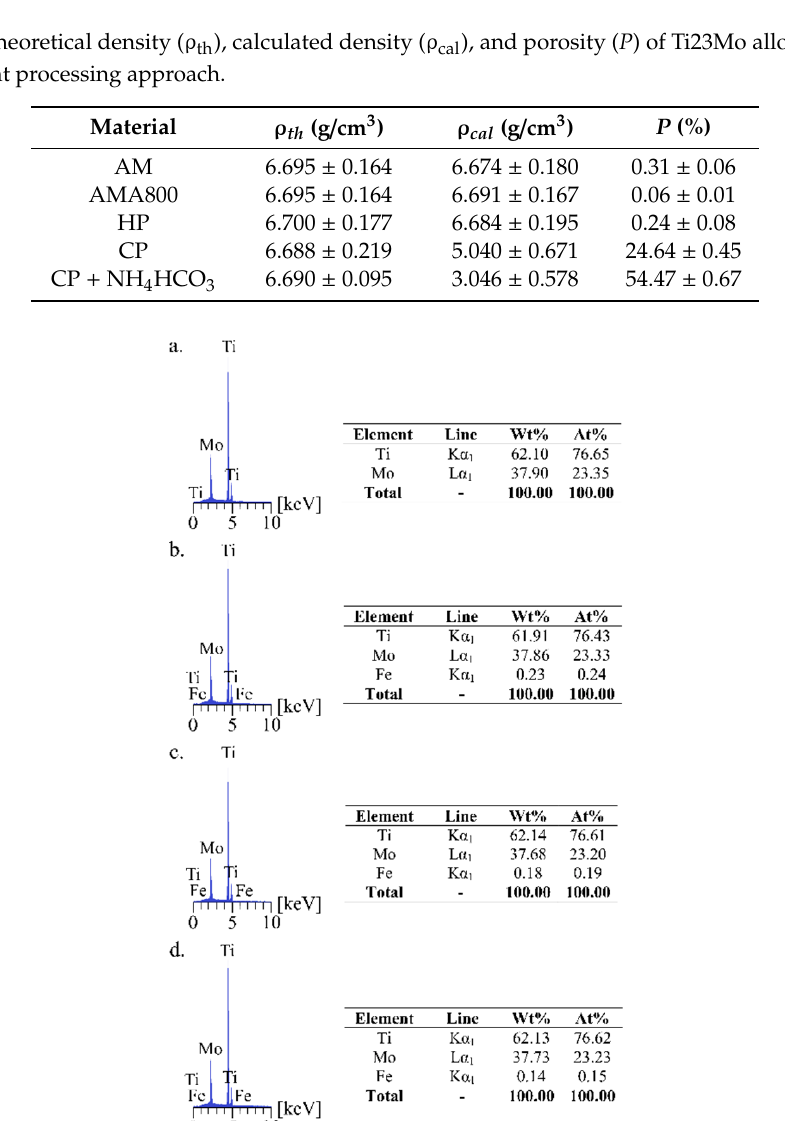
Figure 3. The amount of elements in Ti23Mo alloy: Arc melted ( a ), hot pressed (800 °C/5 min) ( b ), cold-pressed at 800 °C/0.5 h ( c ), cold-pressed with NH 4 HCO 3 at 1150 °C/10 h ( d ) with their EDS spectra.